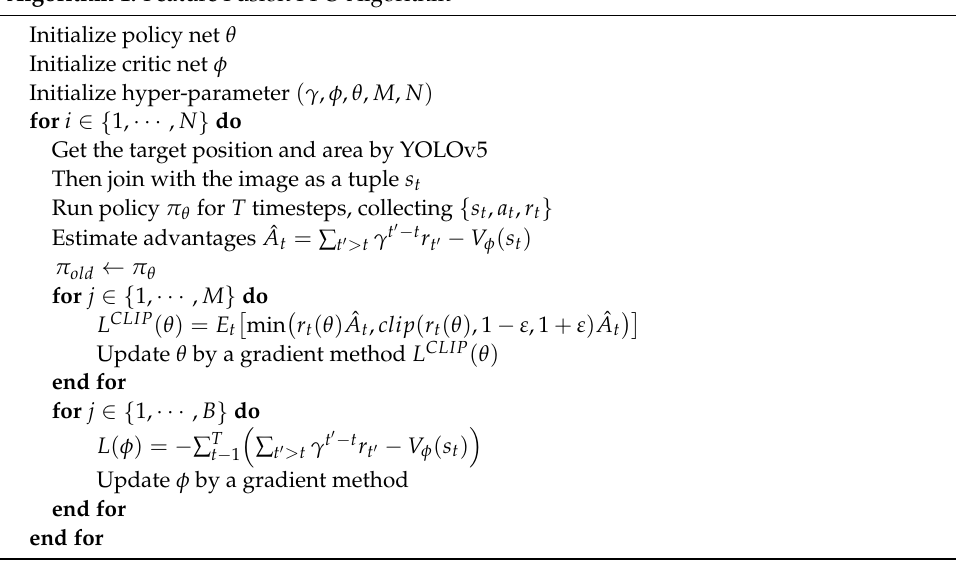
Algorithm 1. Feature Fusion PPO